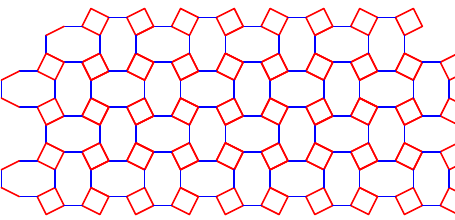
Fig. 40: Octagons has edges from both families green and red. The second case contains families with equal edges between quadrilaterals and octagons.